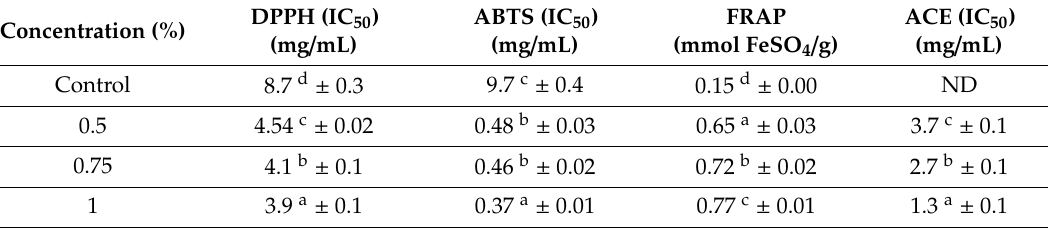
Note: Means ± SD and values with different lowercase letters in the same column indicate significant differences ( p ≤ 0.05) and ND is not detected .